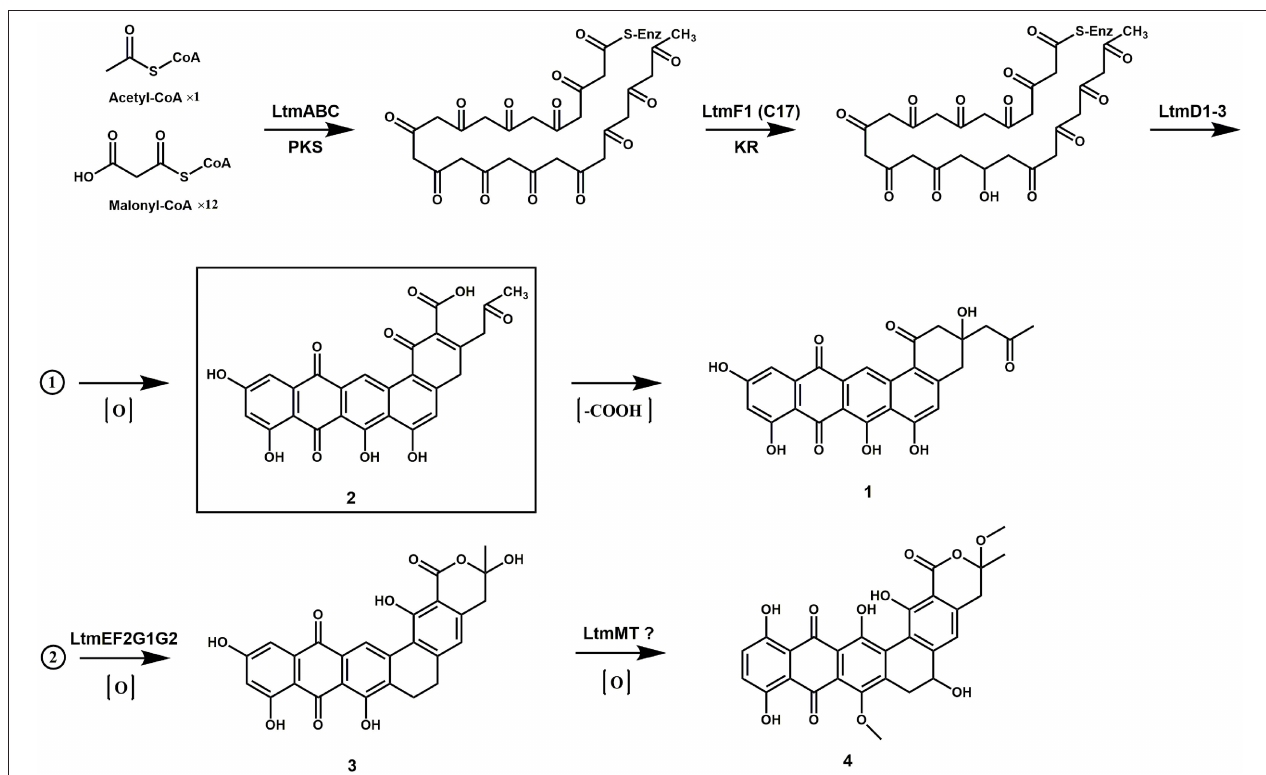
FIGURE 6 | The proposed biosynthetic pathway of